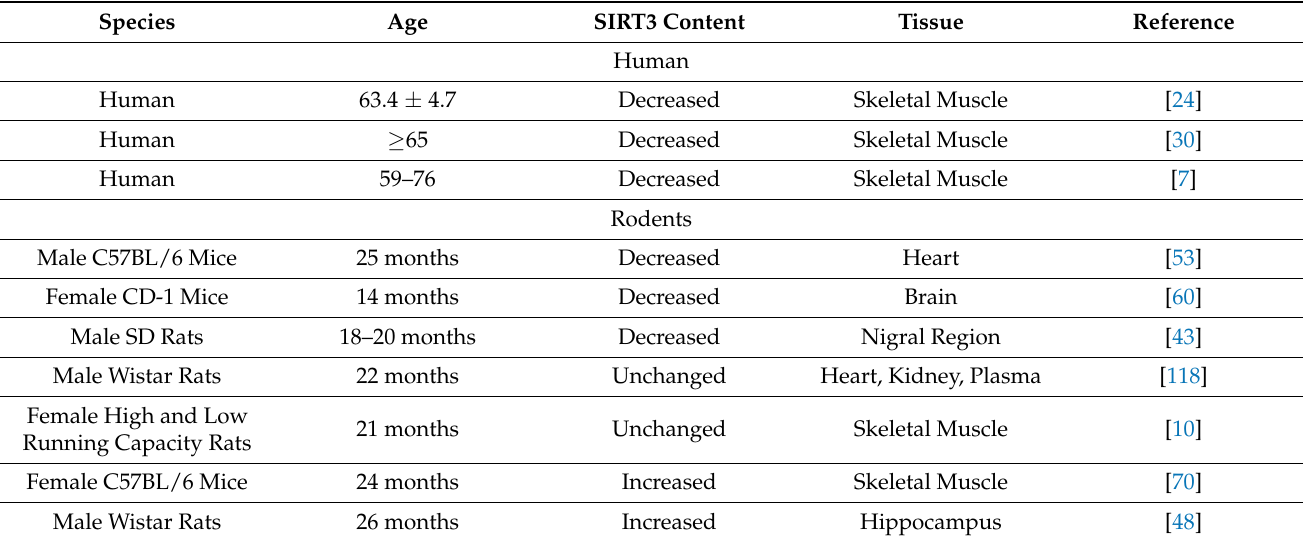
Table 4. The effects of aging on SIRT3